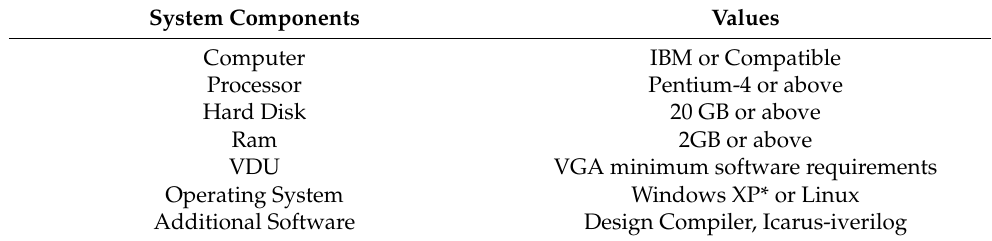
Table 1. System requirements.